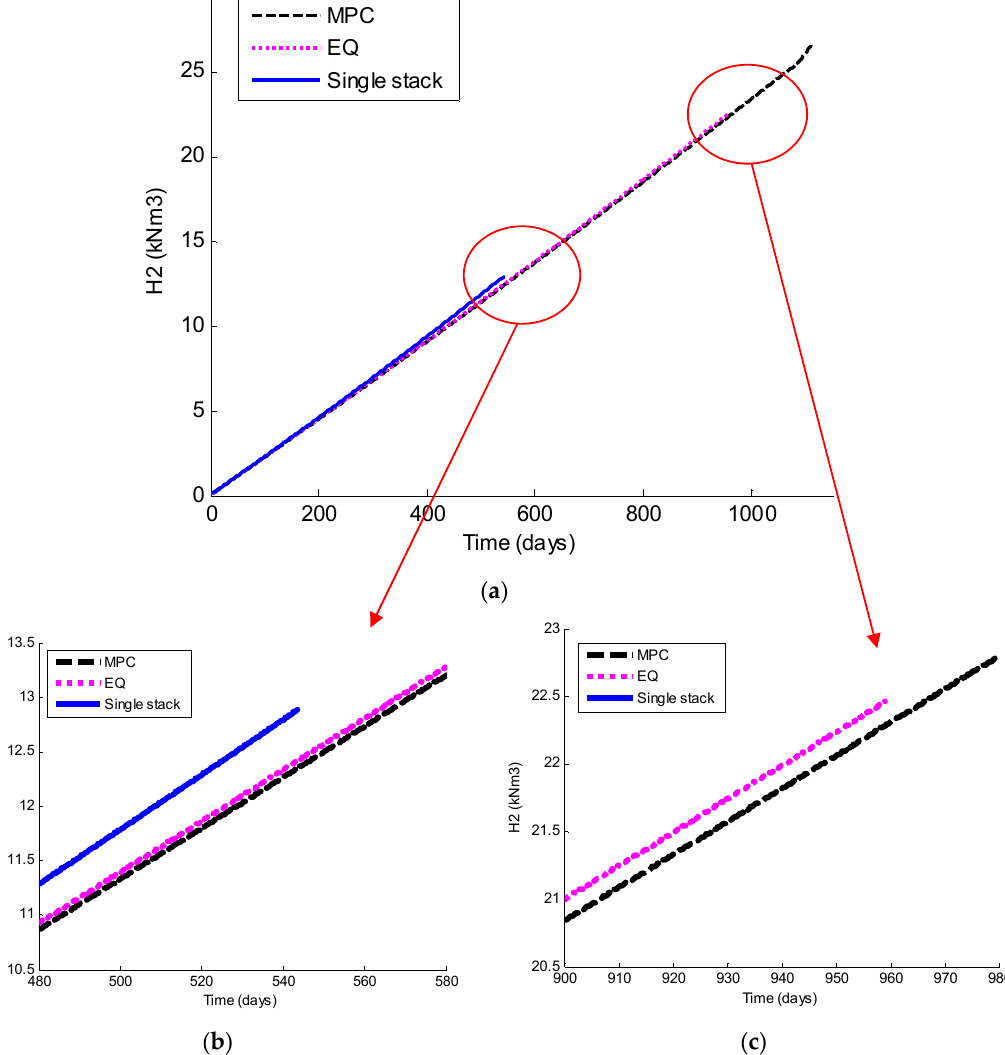
Figure 6. ( a ) Hydrogen consumption of the FC system in the three cases (single-stack FC system, multi-stack FC system with equal power distribution, and multi-stack FC system with MPC controller). ( b ) Detail to highlight the multi-stack FC system with MPC regarding the single stack system. ( c ) Detail to highlight the multi-stack FC system with MPC regarding the multi-stack FC system with equal power distribution (1 kNm 3 = 10 3 Nm 3 ).